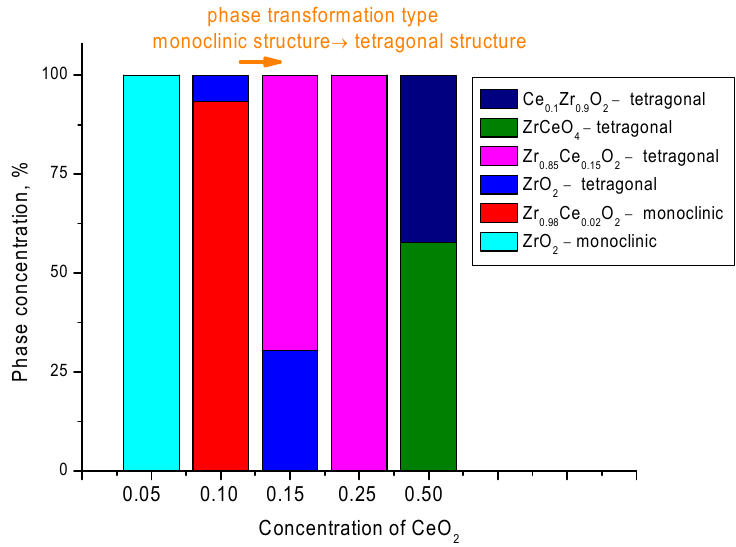
Figure 3. Phase composition diagram of synthesized (1 – x)ZrO 2 − xCeO 2 ceramics. As can be seen from the data presented in the phase composition diagram, the pro- cesses of phase transformations of the monoclinic → tetragonal structure type can be divided into the following stages depending on the concentration of CeO 2 in the composi- tion of ceramics. The first stage is characterized by the nucleation of the ZrO 2 tetragonal phase at a CeO 2 content of 0.1; at the same time, the formation of this phase is also ac- companied by the dominance of the Zr 0.98 Ce 0.02 O 2 substitution phase with a monoclinic type of crystal lattice. With an increase in the CeO 2 concentration, the formation of the Zr 0.85 Ce 0.15 O 2 phase is observed, which, at a CeO 2 concentration of 0.20, leads to the for-